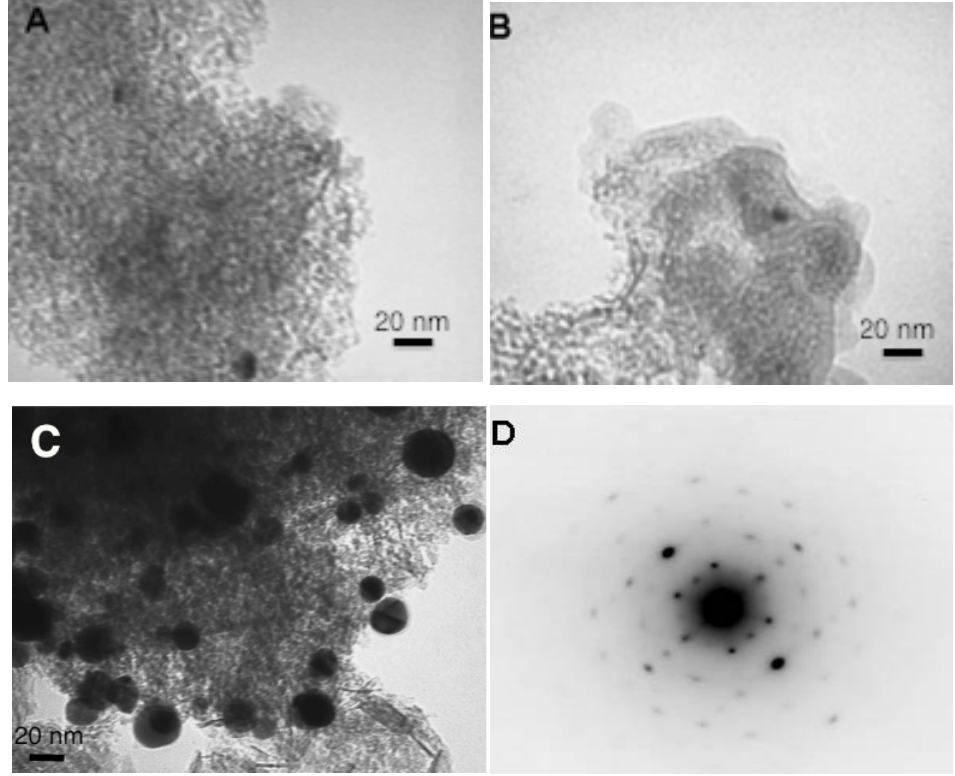
O MOD (citrate); ( B ) Au/20IL/ γ -Al 2 3 O MOD (NaBH —acetone); ( D ) Diffraction of the gold 2 3 4 O MOD (NaBH 2 3 4